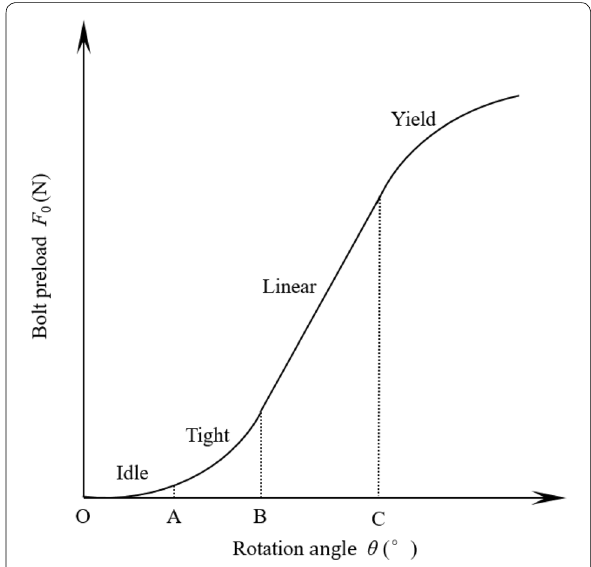
Figure 3 Relationship between bolt load and deformation [5]